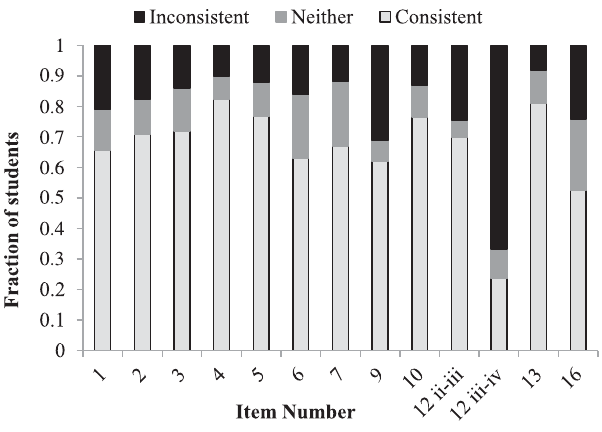
FIG. 6. Fraction of students coded as “ consistent ” (at least one consistent reasoning element and no inconsistent ones), “ incon- sistent ” (any inconsistent reasoning elements), or “ neither ” (neither consistent nor inconsistent reasoning elements) on each of the questions that have consistency checks. Note that there are no consistency checks on questions 8, 11, 14, and 15, but there are two possible consistency checks in Q12: between subparts ii and iii, and between subparts iii and